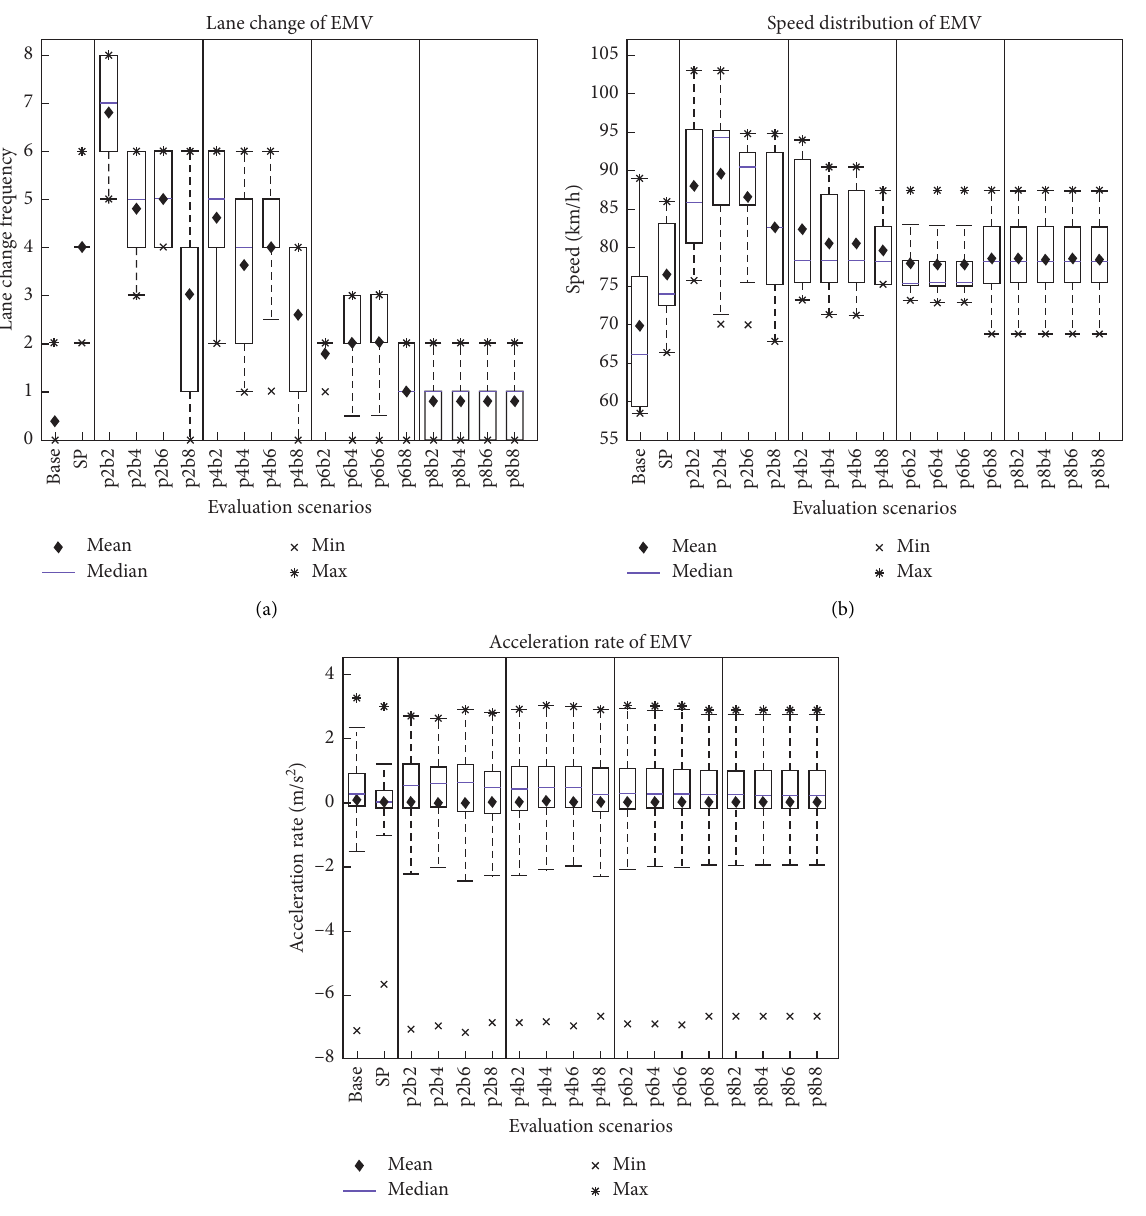
Figure 5: Driving maneuvers. (a) Lane change frequency. (b) Speed. (c) Acceleration rate (m/s 2